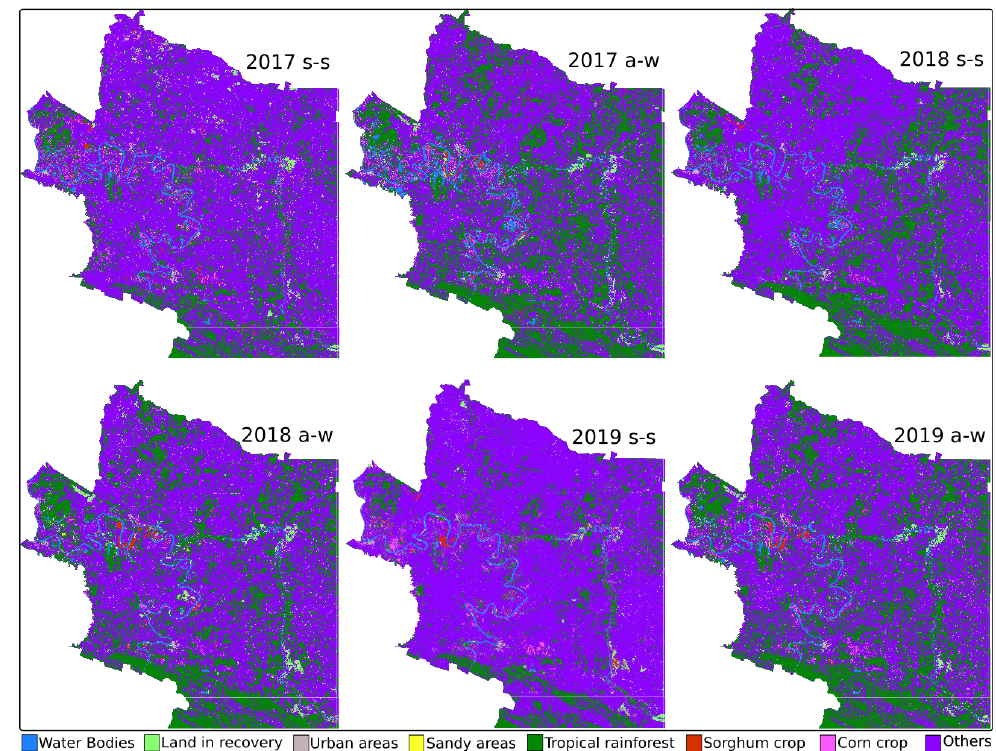
Figure 4. SVM-generated maps. Table 7. Land-use coverage classified by SVM. Coverage in